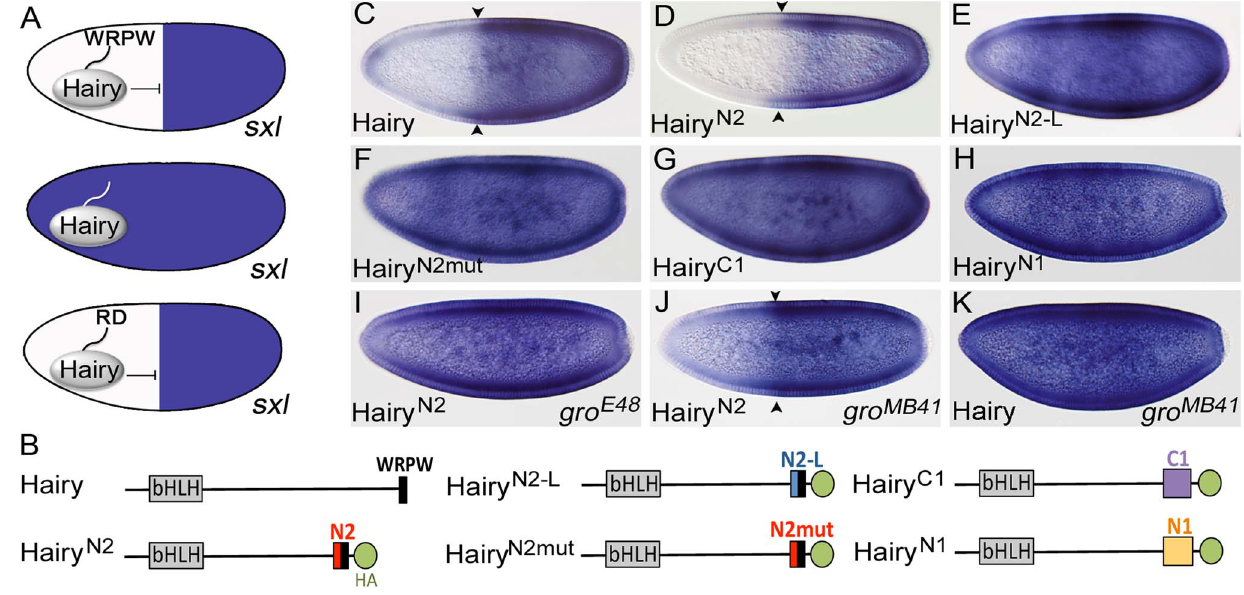
Fig. 4. N2 is a Gro-dependent repressor motif. (A) Schematic representation of the Sxl repression assay. In this assay, expression of Hairy under the control of the hb promoter in the anterior region of the embryo leads to repression of Sxl transcription (blue) in females (top). Repression depends on the WRPW motif of Hairy (middle), but replacement of this motif with autonomous repressor domains (RD) restores repression function (bottom). (B) Diagram of Hairy and Hairy fusion constructs tested in the Sxl assay; all fusions carry a C-terminal HA tag (see Materials and Methods). (C- K) Effects of Hairy constructs on Sxl expression in otherwise wild-type or gro mutant embryos; all images correspond to Sxl expression in female embryos. Arrowheads indicate borders of transcriptional repression. Note that Hairy N2 does not cause complete repression of Sxl in g ro MB41 embryos (J); this may reflect a loss of function, in this genetic background, for endogenous Hairy-related factors such as Deadpan that normally contribute to Sxl repression [46].